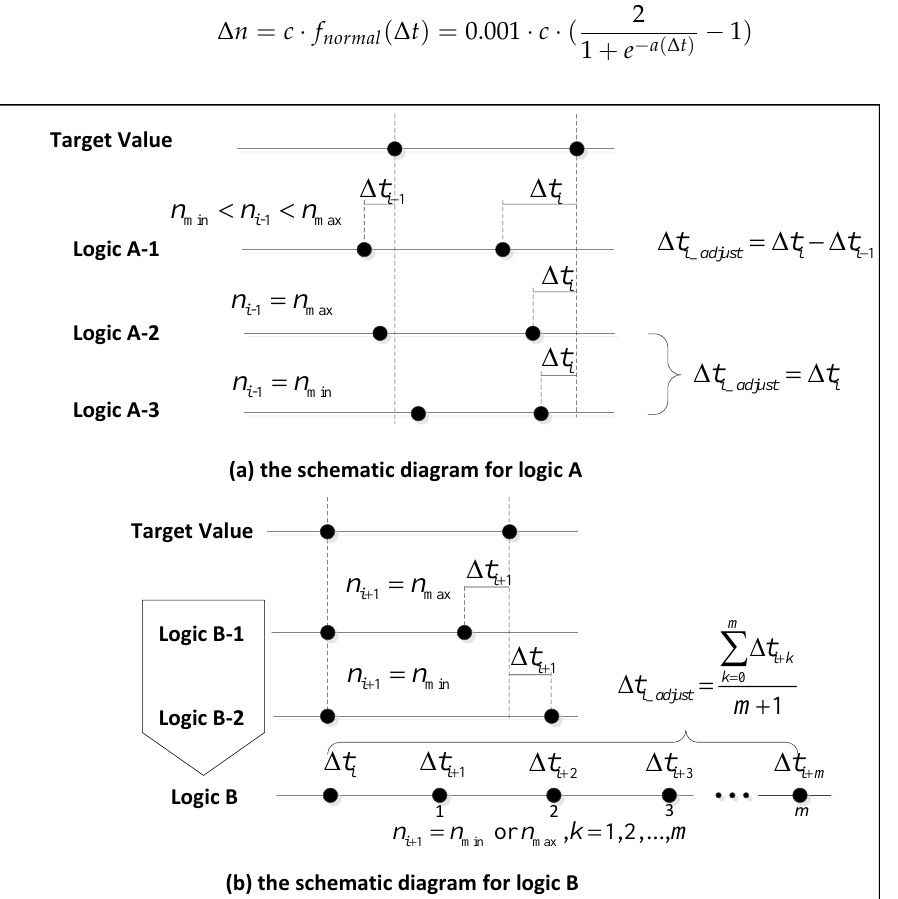
(b) the schematic diagram for logic Figure 6. Correction